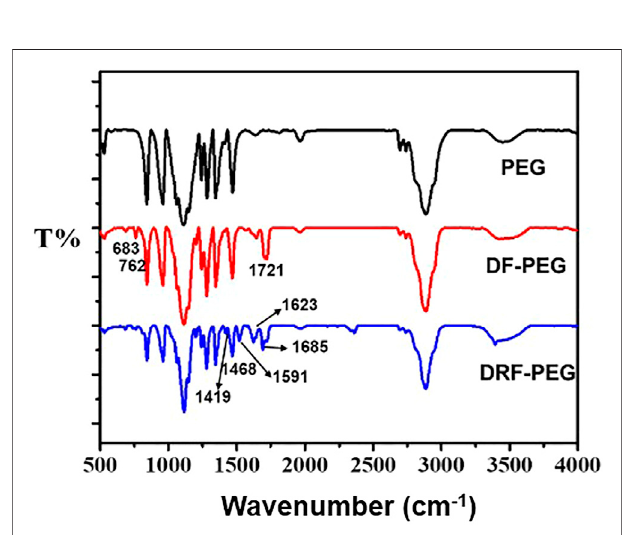
FIGURE1| FT-IRspectraofpoly(ethyleneglycol(PEG),di-benzaldehyde terminated poly (ethylene glycol) (DF-PEG), and polymeric sensor containing both PEG chain and rhodamine moiety